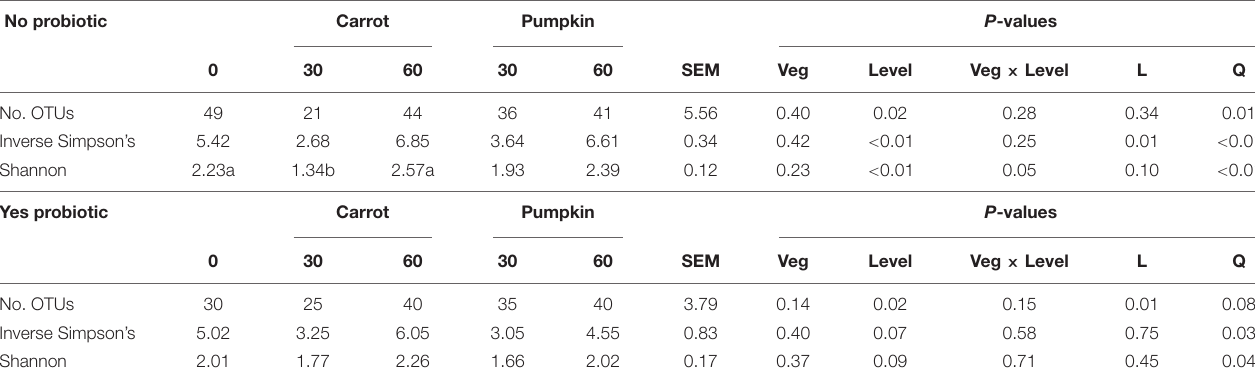
OTUs, operational taxonomical units; SEM, standard error of the mean; Letters a and b indicate differences between treatments (P ≤ 0.05) and between levels within the vegetable type (i.e., interaction Veg × Level was split by vegetable). P-values for Shannon’s and inverse Simpson’s diversity indices for interactions Veg × Prob, Level × Prob, and Veg × Level × Prob were ≥